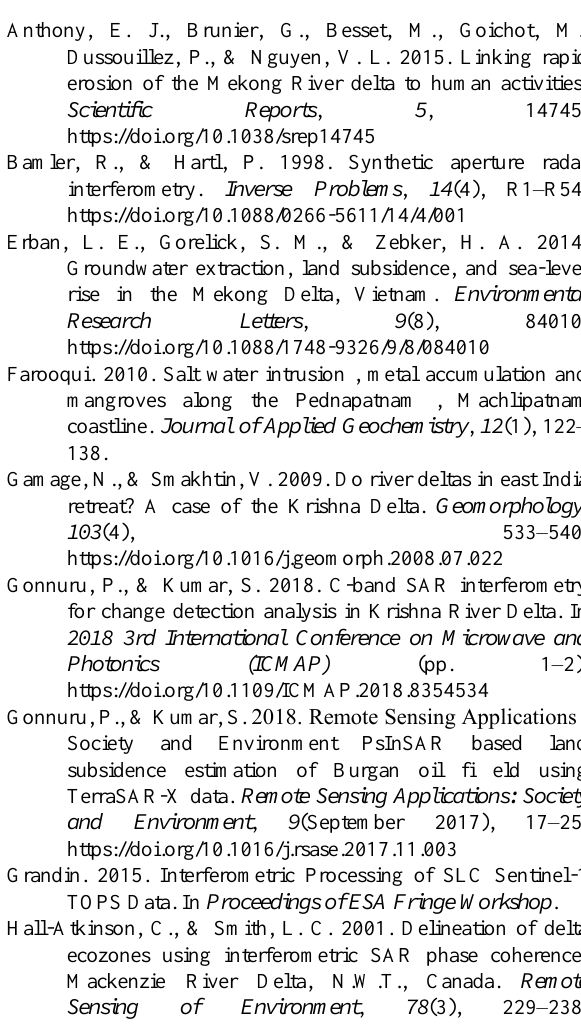
Figure 9: Integrated Cumulative Displacement Map The integrated cumulative displacement map is shown in Figure 9. The map highlights the areas subjected to displacement during the nine-month period. The colour bar represents the maximum and minimum range of displacement